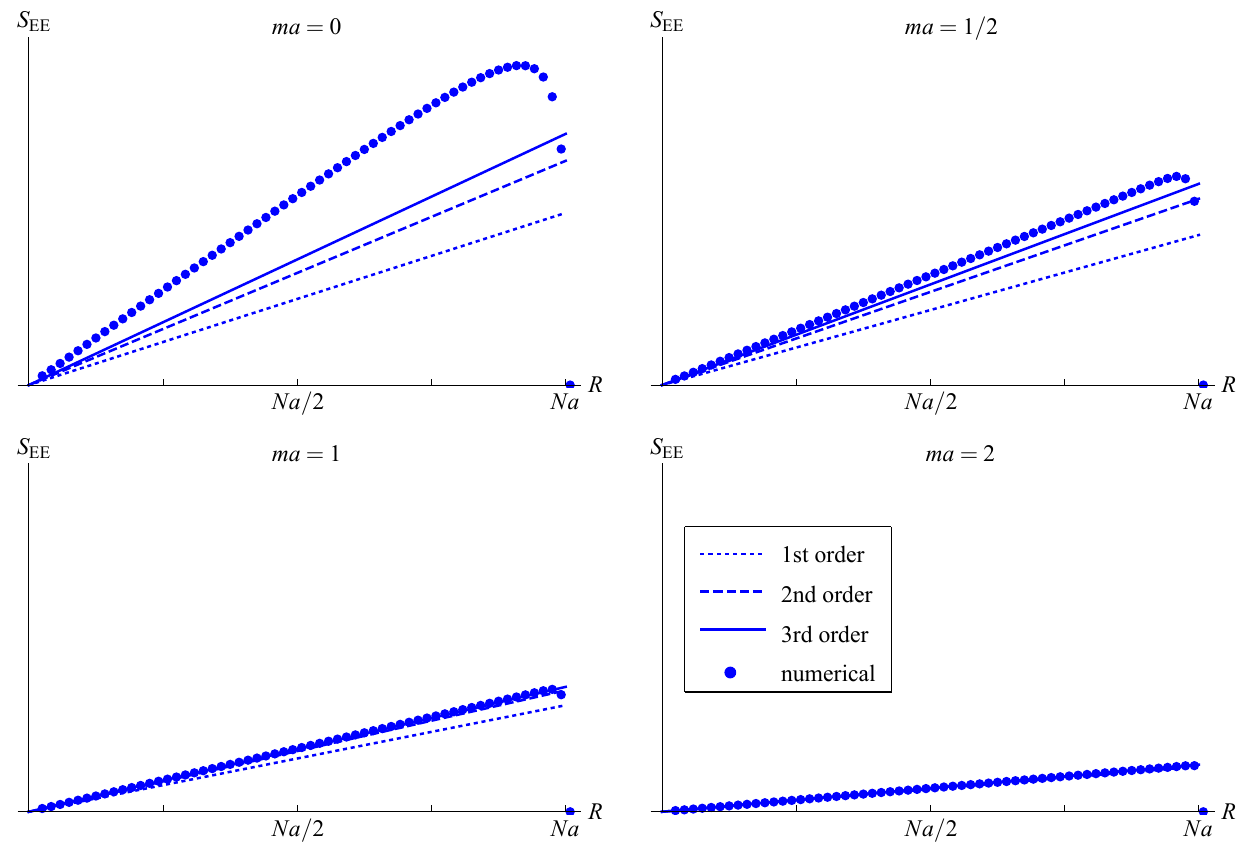
Fig. 2 Comparison of the numerical calculation of entanglement entropy to the perturbative area law formulae at first, second and third order in the inverse mass expansion. The vertical axes have the same scale for all values of the mass